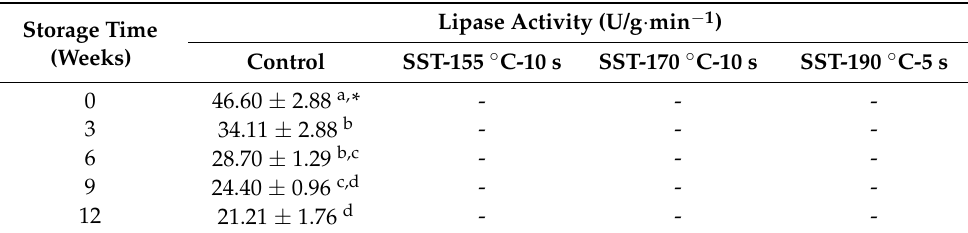
Table 1. Effect of superheated steam treatment on lipase activity of dried whole wheat noodles during storage.